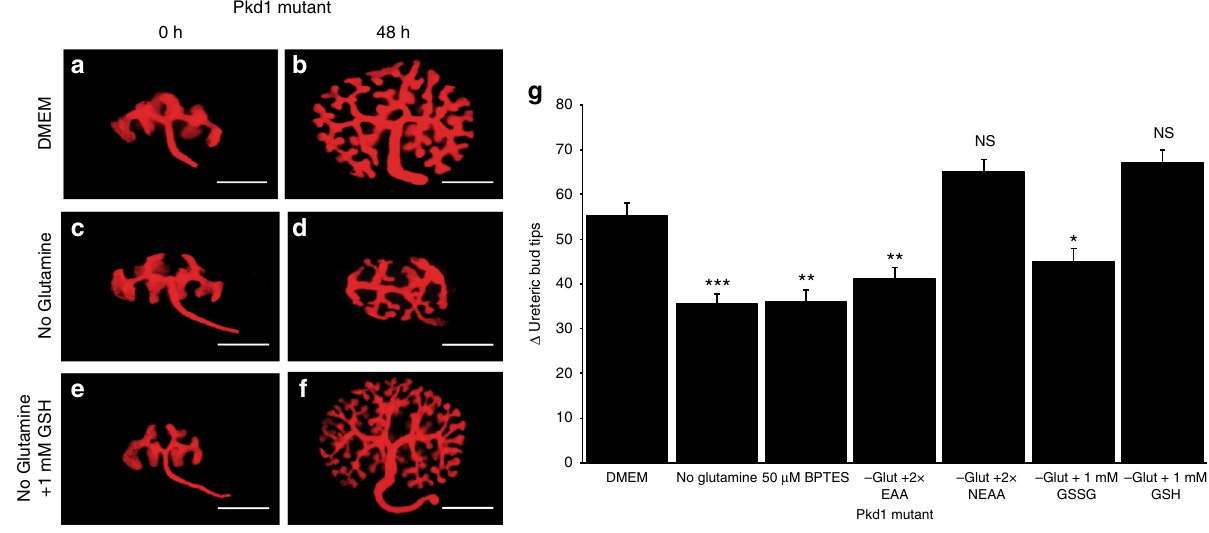
Fig. 5 Embryonic Pkd1 mutant collecting ducts are dependent on glutamine for growth. Live images of e12.5 HoxB7-Cre; Pkd1 fl ox/ fl ox ; RosaTomato kidneys after 0 ( a , c , e ) or 48 ( b , d , f ) hours of culture in complete media (DMEM, a , b ), glutamine-de fi cient media ( c , d ) or glutamine-de fi cient media supplemented with 1 m M GSH ( e , f ). g Quanti fi cation of the change ( Δ ) in branch number (number of ureteric bud tips after 48 h — ureteric bud tips at 0 h) for E12.5 HoxB7-Cre; Pkd1 fl ox/ fl ox ; RosaTomato kidneys grown in DMEM, DMEM-glutamine, DMEM + BPTES, DMEM-glutamine + 2× essential amino acids, DMEM-glutamine + 2× non-essential amino acids, DMEM-glutamine + 1 m M oxidized glutathione (GSSG), or DMEM-glutamine + 1 m M reduced glutathione (GSH). Statistical analysis is relative to Pkd1 mutant grown in complete media (DMEM). n = 10 for each media condition. Statistical analysis via Mann − Whitney U -test. * p < 0.05, ** p < 0.01, *** p < 0.001, NS not signi fi cant. Error bars shown as mean ± standard error of the mean (SEM). Scale bars